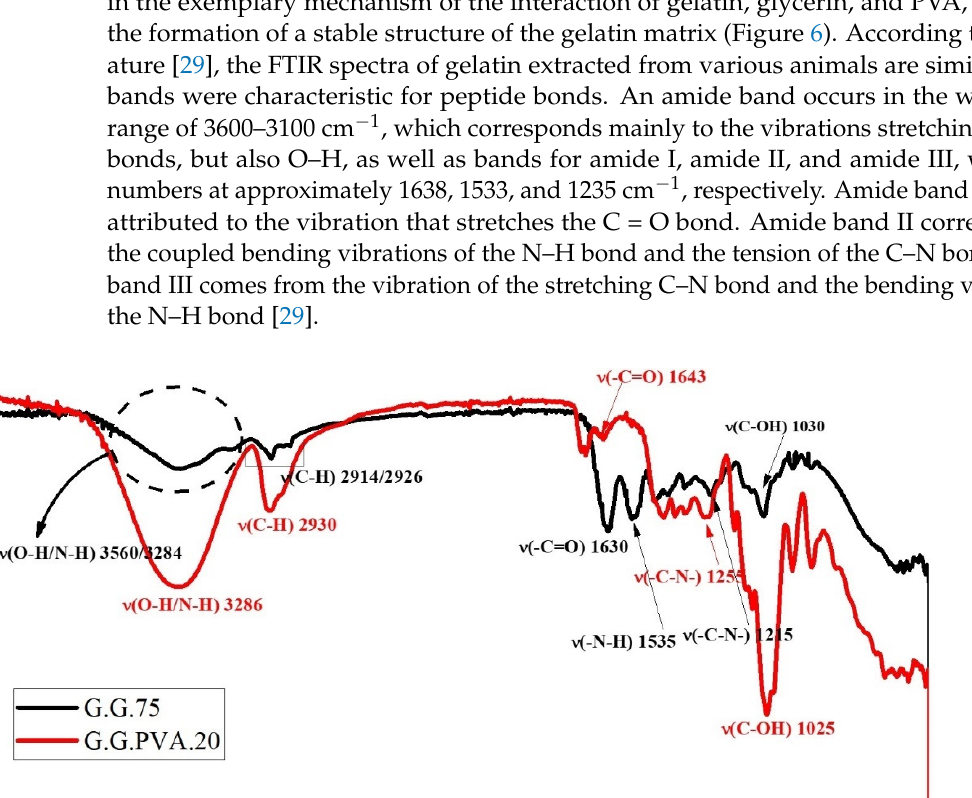
Figure 6. Probable mechanism of interaction of gelatin, PVA, and glycerin mac- romolecules, leading to the formation of a stable gelatin/PVA matrix. On the spectra of G.G.75 (Figure 5), as well as signals characteristic of amide bands (Table S1 in Supplementary), additional bands responsi- ble for asymmetrical and symmetrical vibrations were noted for stretching C–H bonds in the CH 2 groups in the range of 2914 and 2826 cm -1 . In the FTIR spectrum of the PVA-based polymer, characteristic bands appeared in the wavenumber range of 3600–3100 cm -1 , corresponding to the vibration stretching the O–H bond (Figure 5). The maximum of this band at 3286cm -1 may indicate the interaction of hydroxyl groups with hydrogen bonds. Already at the stage of introducing glycerin into the composition with gelatin, it is clearly visible that the interaction is en- hanced by the increased number of hydroxyl groups in the system (Figure 6). This leads to the creation of new active donor–acceptor sites in the mac- romolecule of the gelatin matrix [30]. There is a chance for a nucleophilic